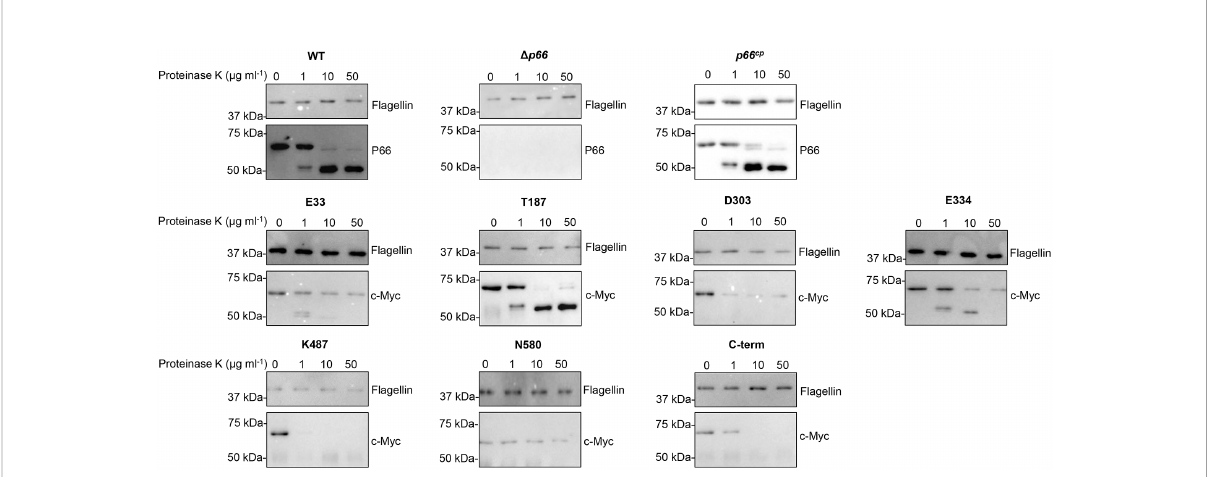
FIGURE 3 B31 A3 c-Myc P66 cp proteins are exposed on the surface on B . burgdorferi . Cells were incubated with increasing concentrations of Proteinase K for one hour at 33°C. Following deactivation of Proteinase K with PMSF, cell lysates were subjected to SDS-PAGE and western blotting. Blots were probed with antibodies to fl agellin and P66 or c-Myc. Blots are representative of at least three independent